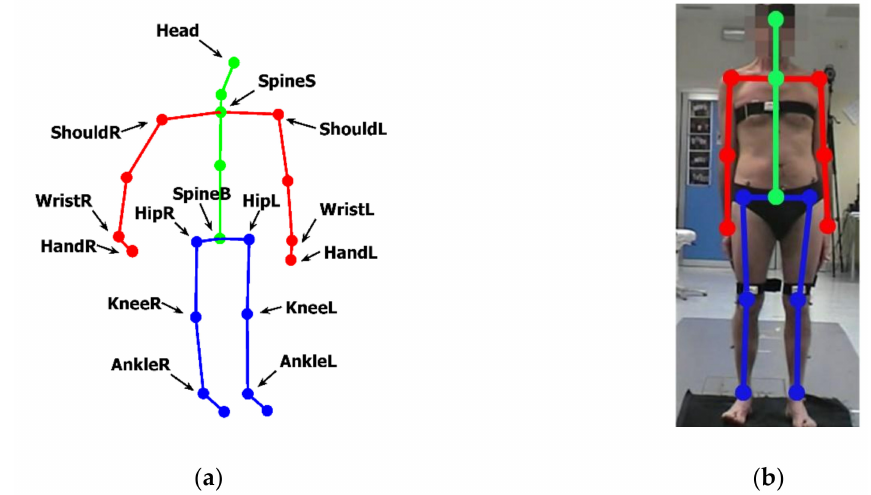
Figure 2. Positions of joints of the skeleton model from Microsoft Kinect SDK: ( a ) three-dimensional representation of joints and segments for body vertical axis (green), upper limbs (red), lower limbs (blue); ( b ) two-dimensional re-projection of the same joints and segments on the RGB